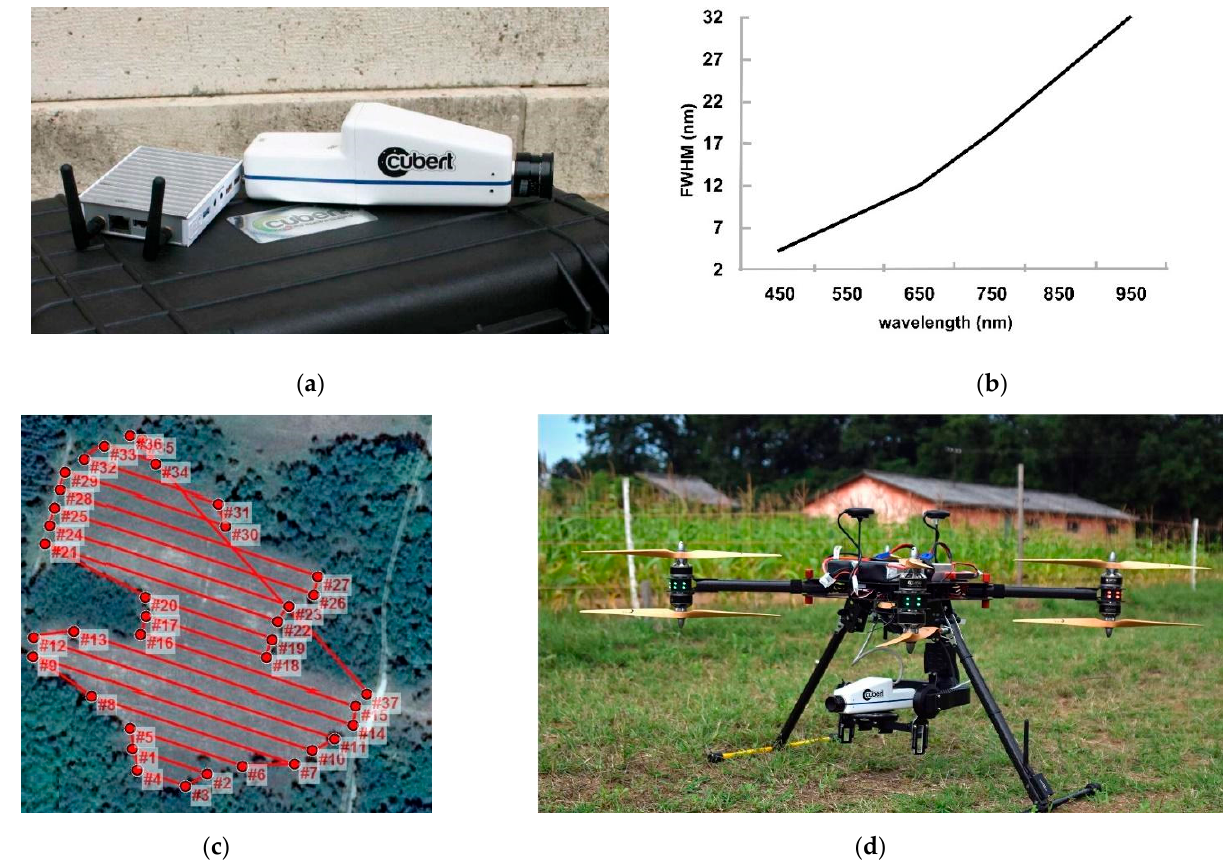
Figure 3. ( a ) Cubert UHD-185 HS camera with the Fitlet mini PC; ( b ) FWHM of the spectral range increase from 4 nm to approximately 32 nm; ( c ) One of the planned flying routes in the ArduPilot mission planner; ( d ) CarbonCore Cortex X8 octocopter equipped with the Cubert UHD-185 camera.